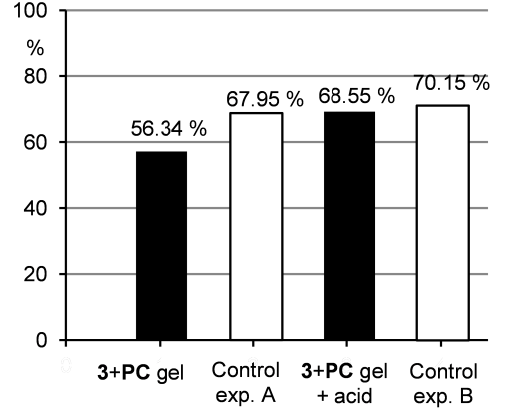
Figure 7. Percentage of PC released to the water layer after ultrasonic